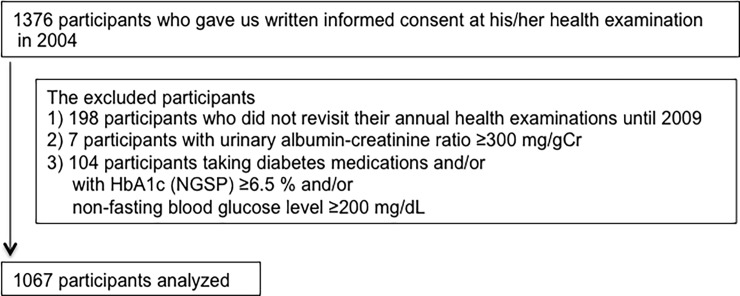
Study participants.